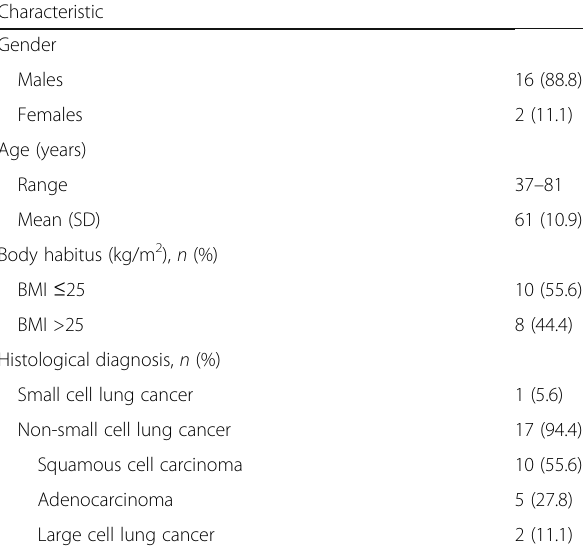
Table 1 Patient characteristics